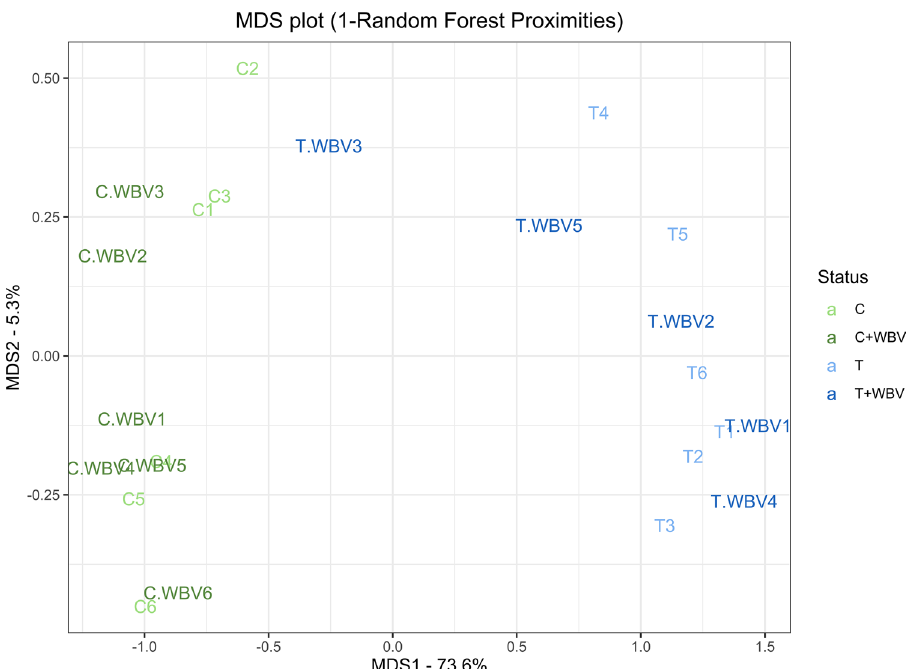
Figure 5. MDS plot (1 – Random Forest Proximities) using 63 variables. Green colour are the control groups and blue colour are the tumour groups, in both the darker colour represents the group with whole body vibration training (WBV).